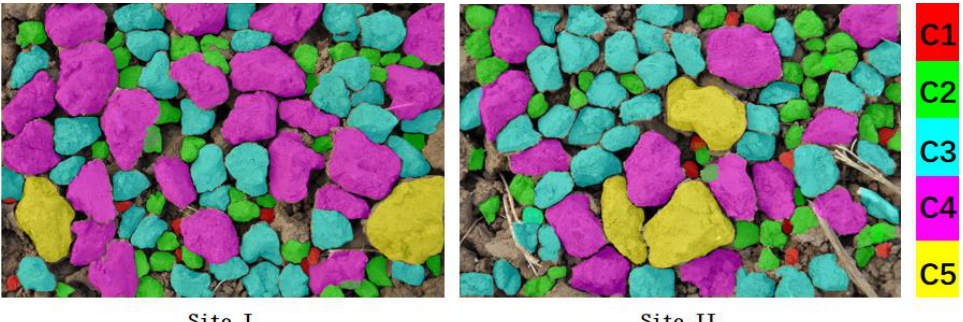
Figure 11. Results of the soil blocks grading.